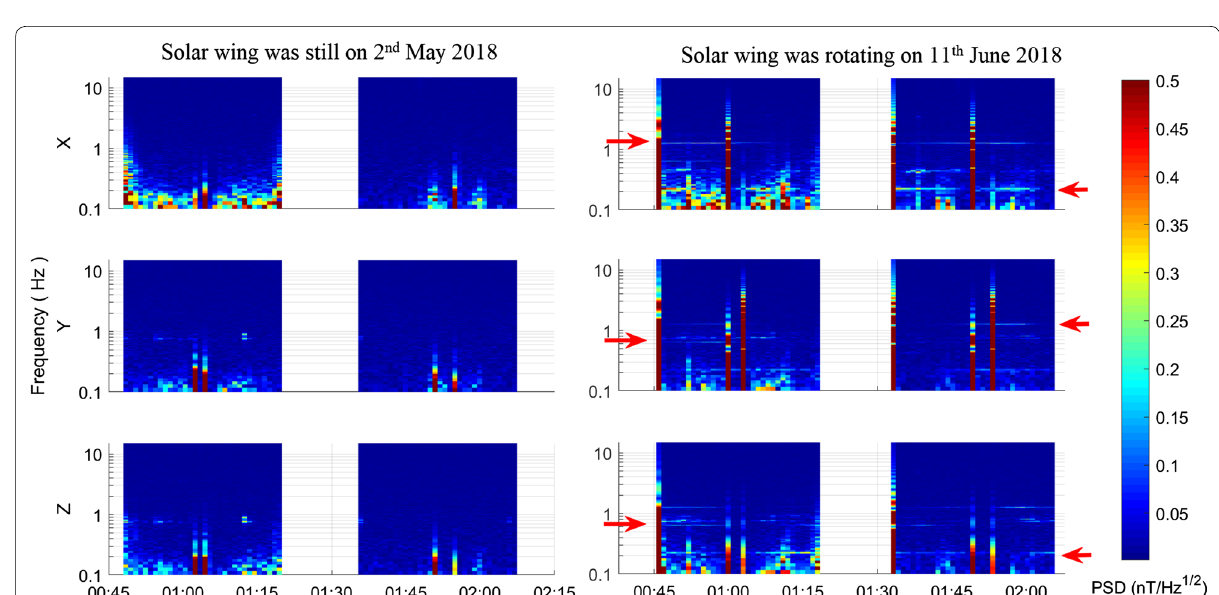
Fig. 17 Influence of the rotation of the solar wing. Two revisit orbits under quiet geomagnetic condition were selected to compare the influence of the rotation of the solar wing. The left panel shows the spectrum of the FGM components when the solar wing does not rotate on 2nd May 2018, while the right panel shows the spectrum when the solar wing rotates on 11th June 2018. Several specific frequency interferences can be identified when the solar wing is